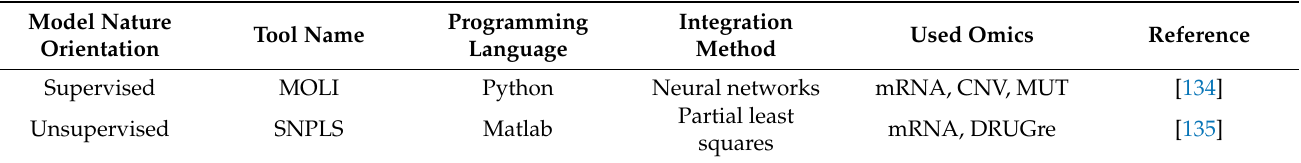
Table 5. Summary of computational tools for drug analysis (drug repurposing and drug discovery) in the field of multi-omics data